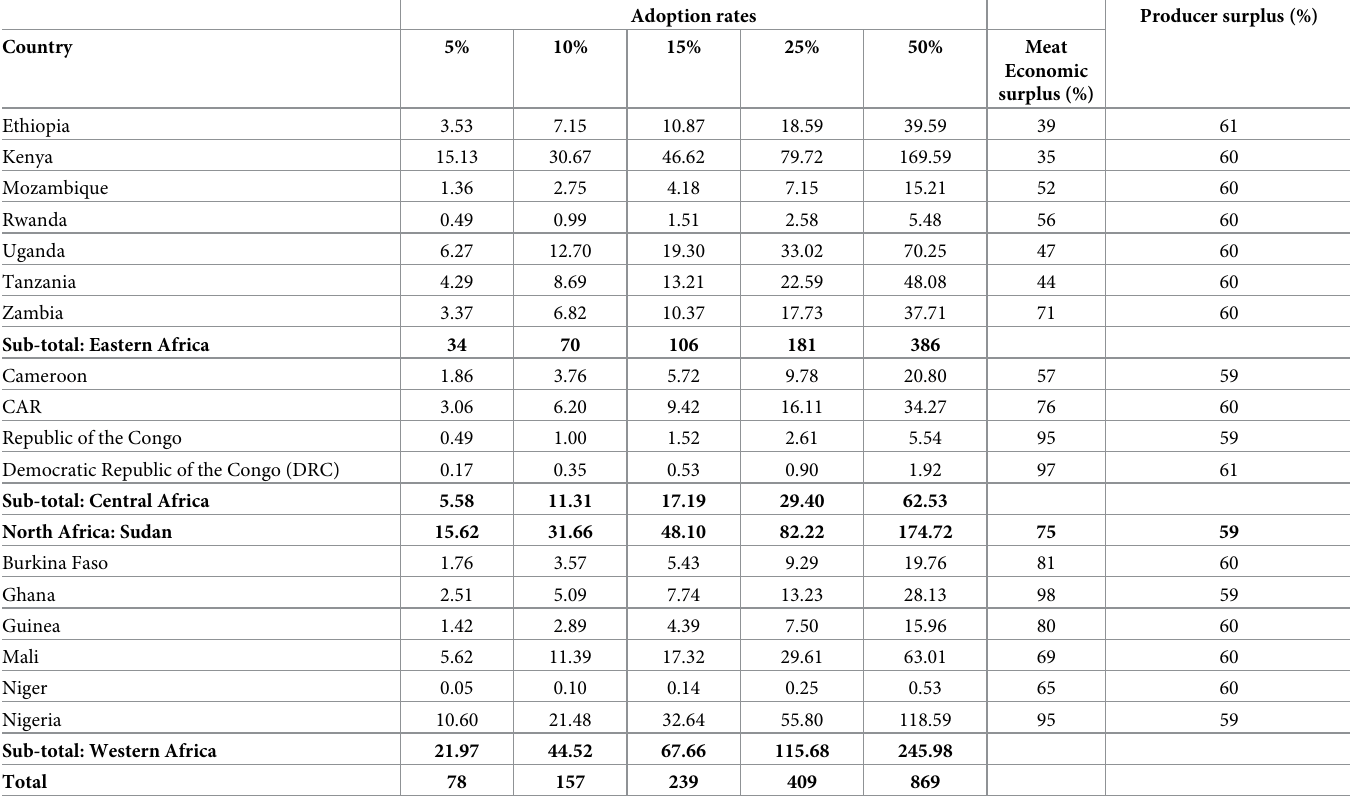
Table 3. Estimated economic surplus from WRB adoption (millions of